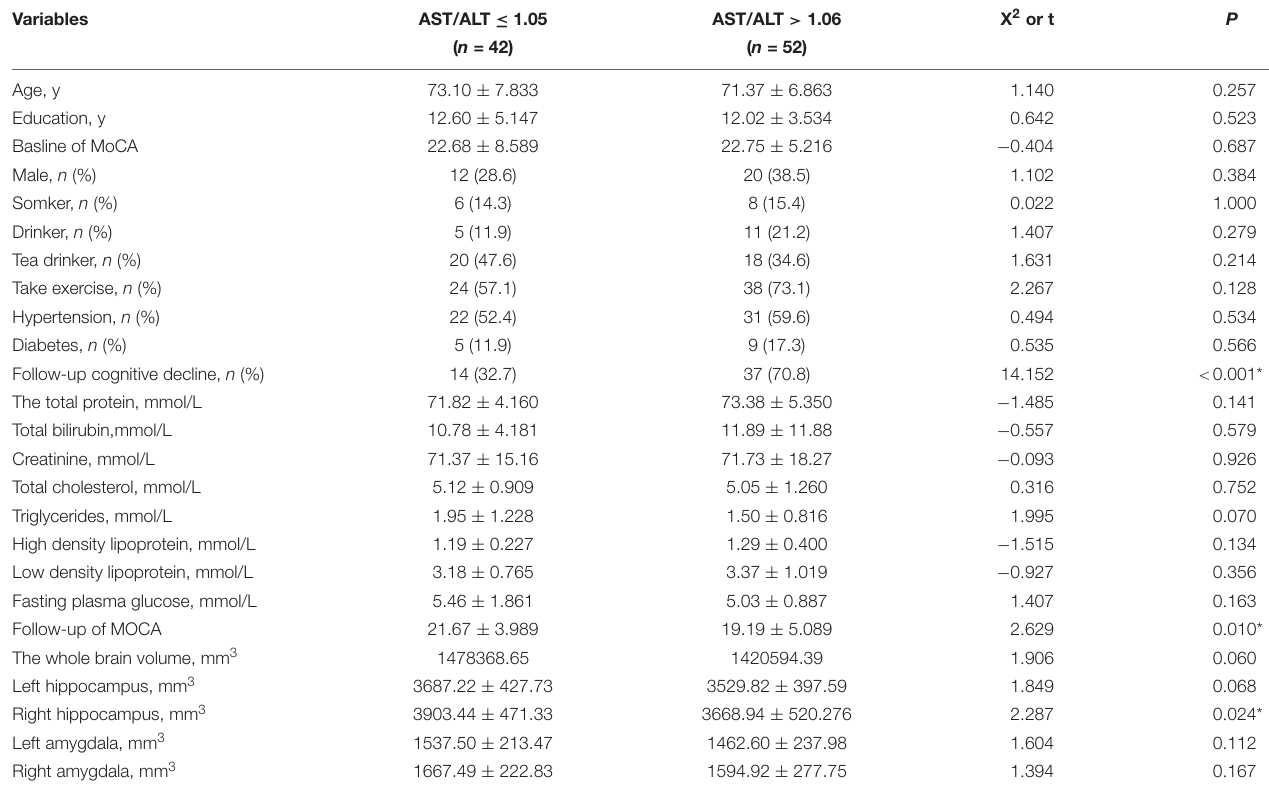
TABLE 5 | Relationship between AST/ALT and baseline demographic characteristics (7-years follow